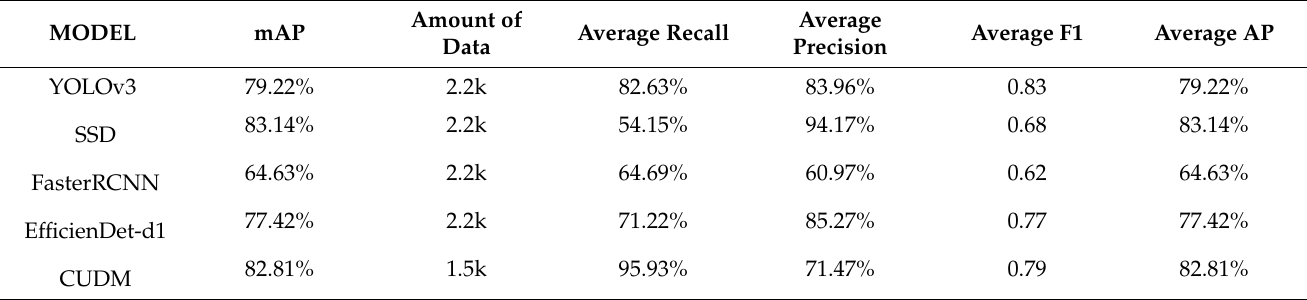
Table 1. Overall performance comparison between CUDM and other